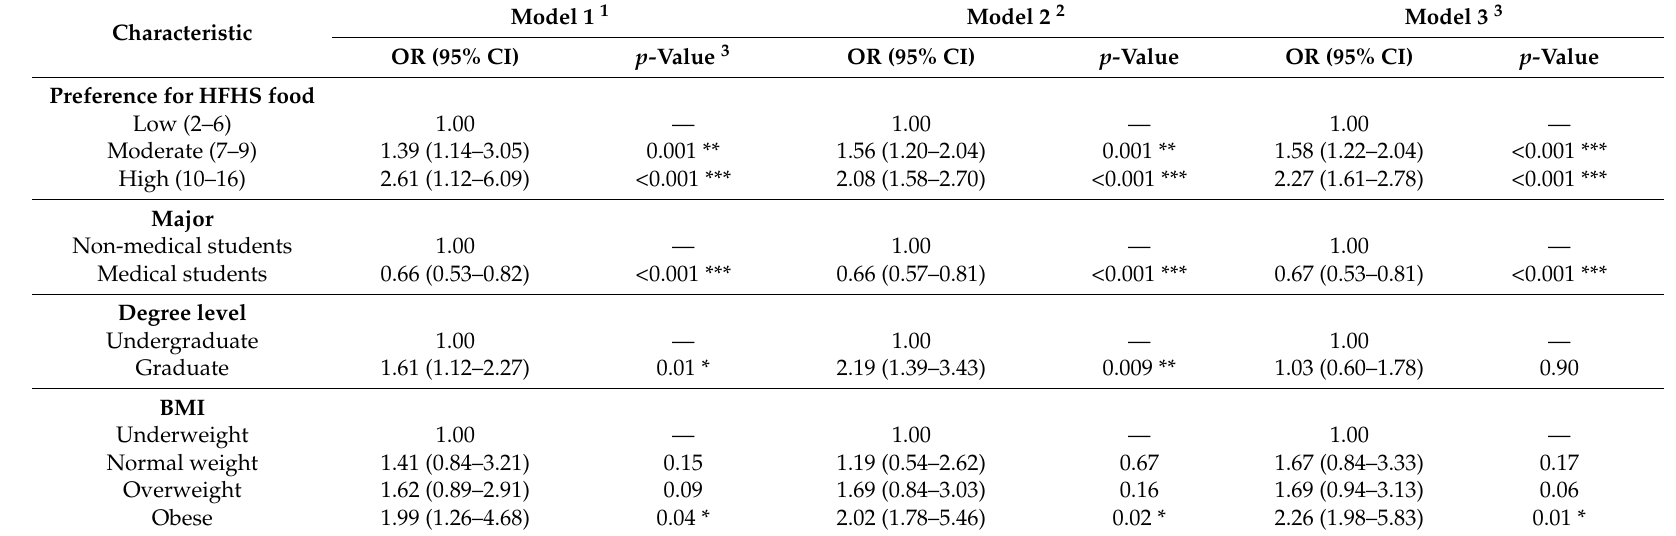
Table 3. Odds ratios (ORs) of take-out food consumption associated with personal and lifestyle